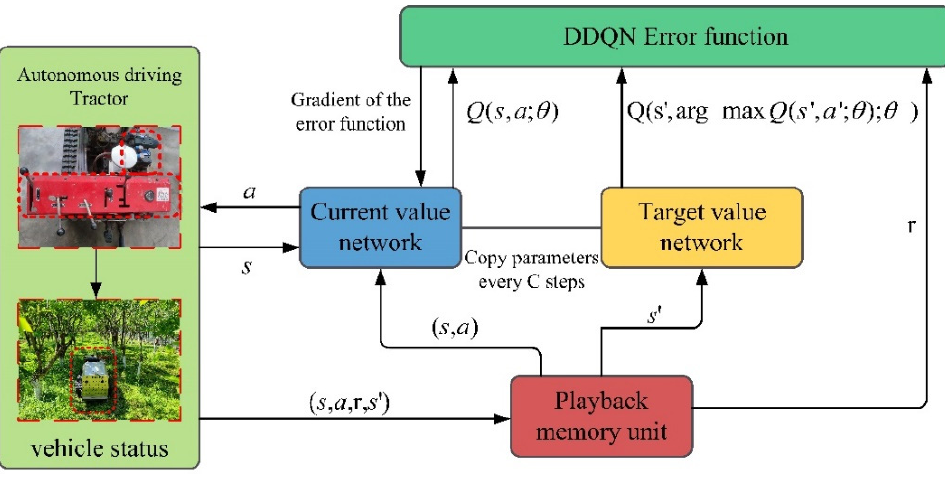
Figure 8. Agent training algorithm flowchart.